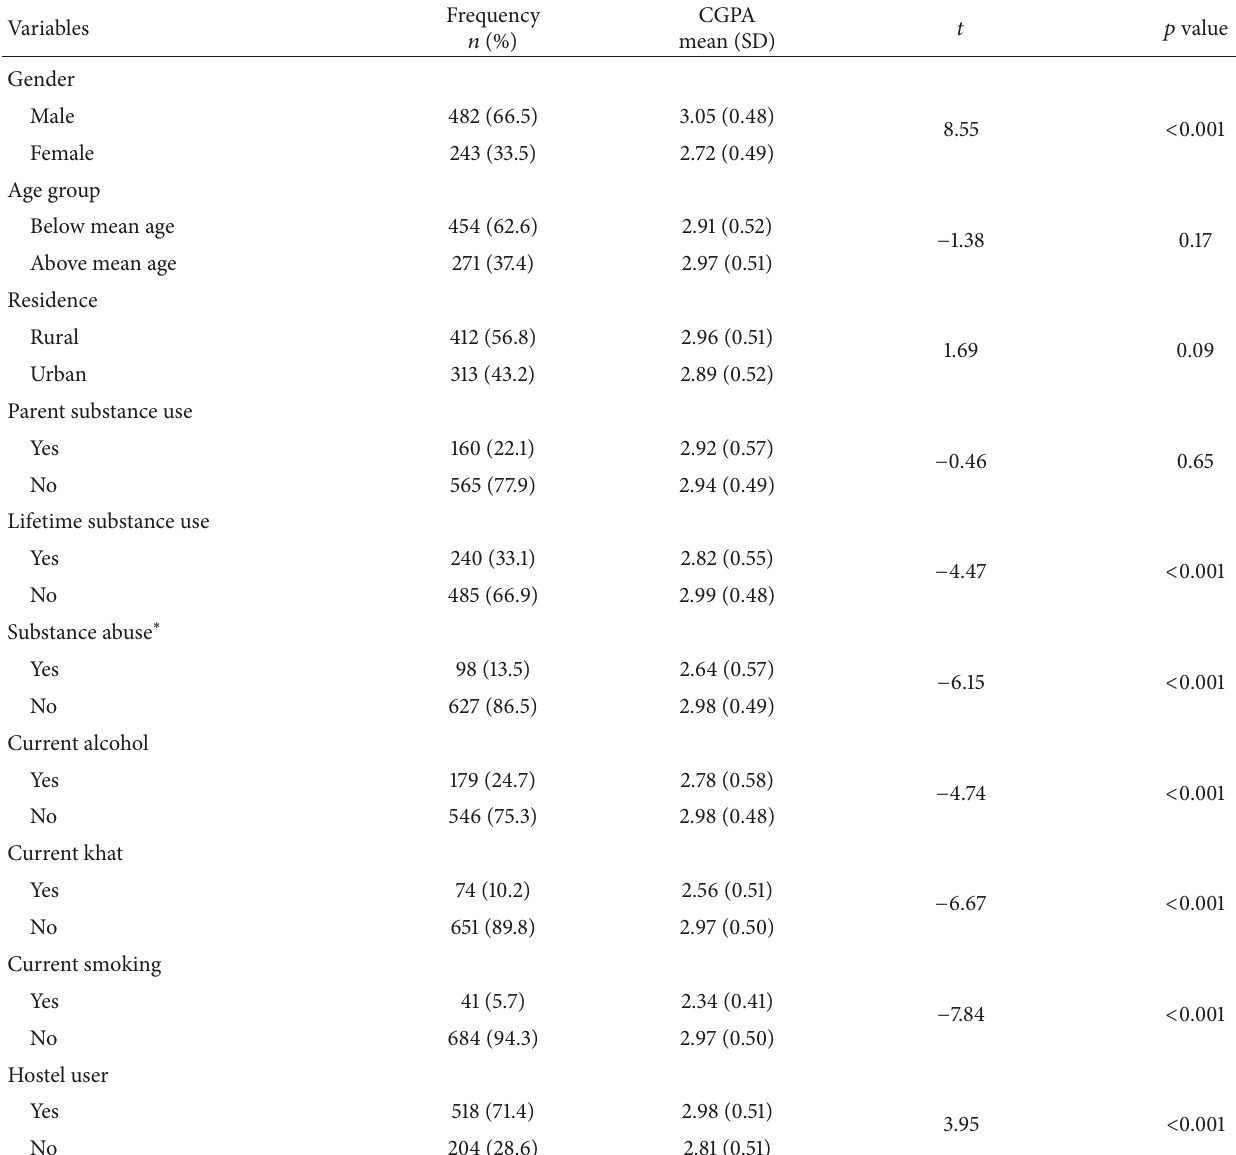
Table 2: Mean difference of CGPA with respect to substance use and other selected variables,